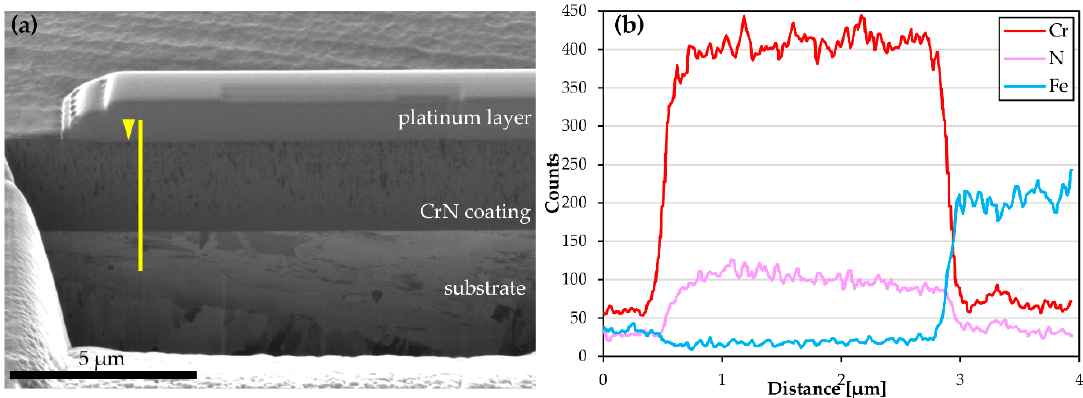
Figure 2. CrN coating in initial state, ( a ) ion induced secondary electron image of CrN coating cross-section, ( b ) chemical composition obtained by EDS analysis along the line depicted in the image (a).